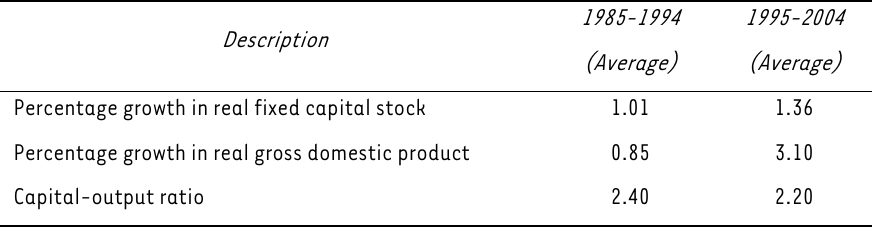
TABLE 1: Fixed capital and output growth in South